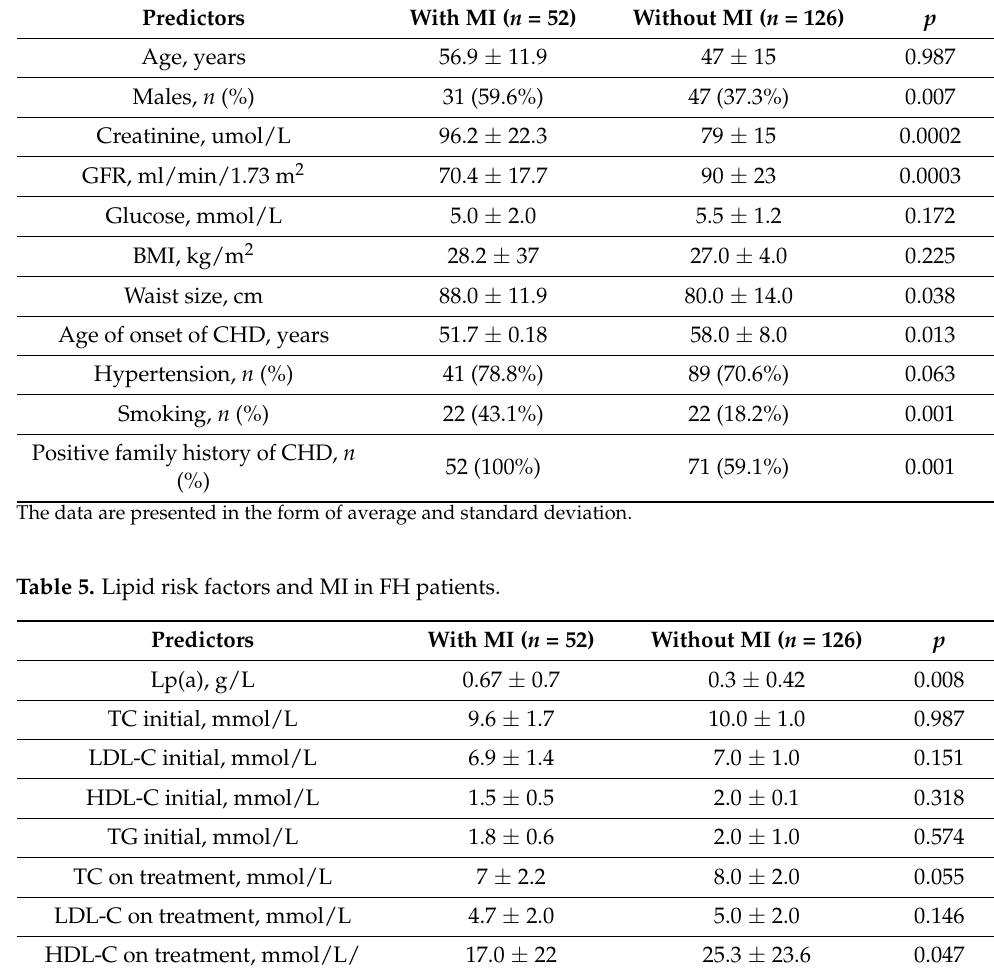
Table 4. Non-lipid risk factors and MI in FH patients.